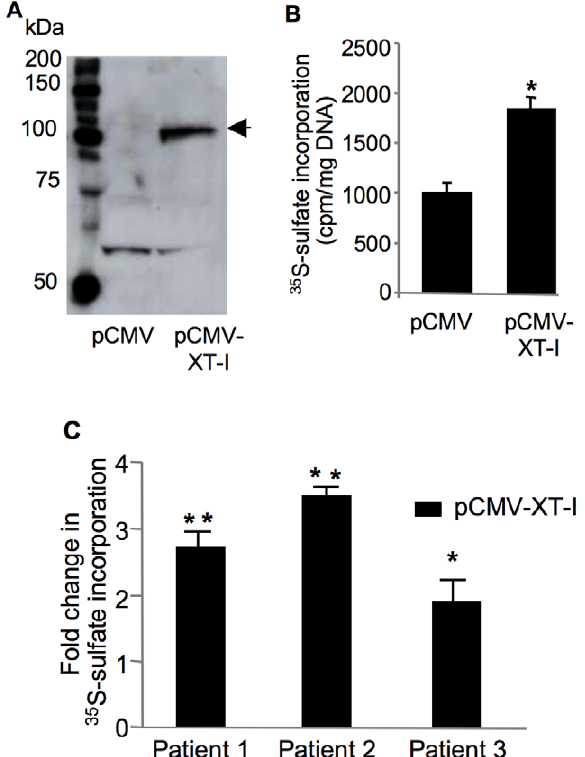
Figure 5. Effect of XT-I overexpression on GAG anabolism in chondrocytes and cartilage. (A) Immunoblot of XT-I protein in pCMV- or pCMV-XT-I-transfected chondrocytes 48 h after transfection. XT-I recombinant protein was indicated by the arrow. (B) GAG synthesis in primary human chondrocytes or (C) in cartilage explants from late OA region of human femoral condyle transfected with pCMV- (control) or pCMV-XT-I vector. XT-I- or mock-transfected cells or cartilage were labeled with 35 S-sulfate, and the amount of 35 S-labeled GAGs was measured 48 h posttransfection. Data are mean 6 SD of 3 experiments per parameter, per joint, per patient. **,*Significantly ( P , 0.01, P , 0.05, respectively) higher than controls.